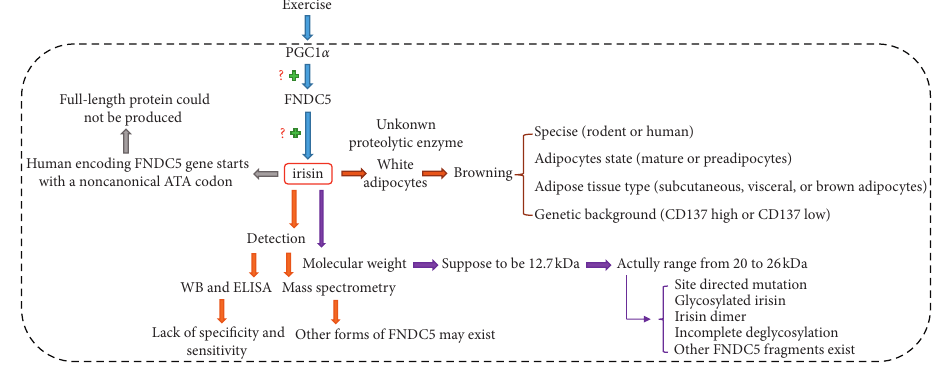
Figure 1: The existing controversies about